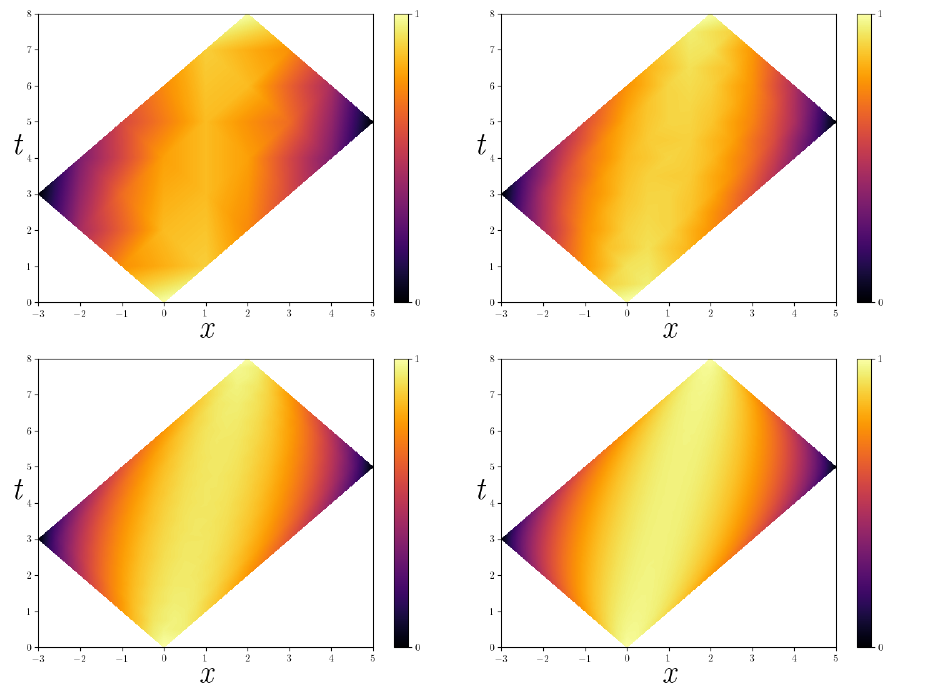
Figure 7. The barycentric-based visit probability for the prism of Figure 3 for (cid:96) values of 8, 16, 32 and